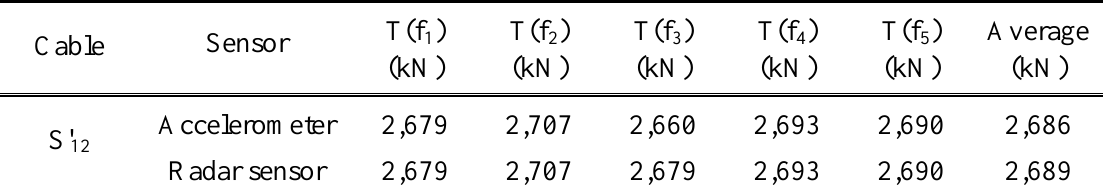
obtained from accelerometer and radar measurements. 12